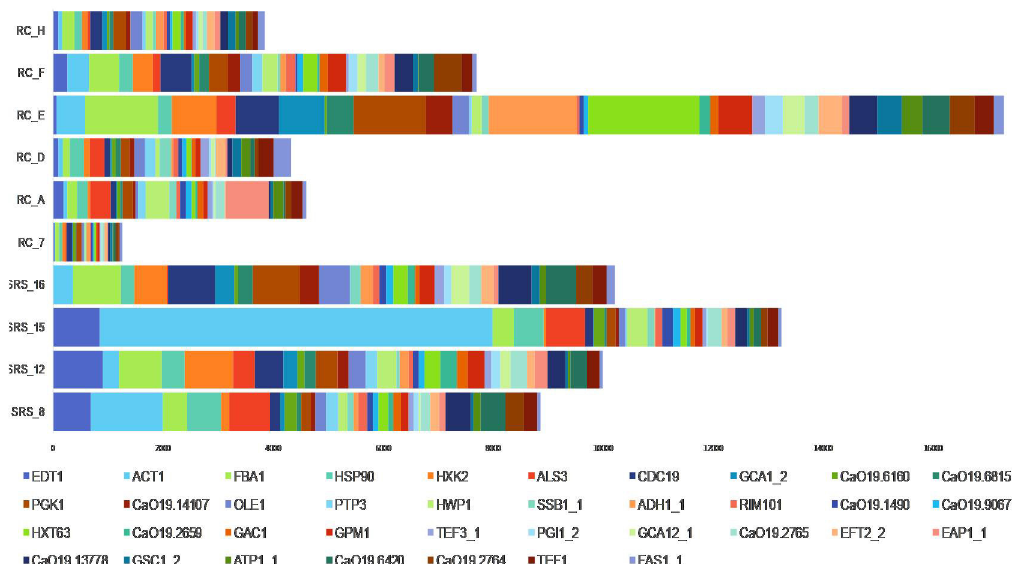
Figure 1- Relative median expression (RME; log10) of genes in the Sound Root Surfaces (SRS; n=4) and Root Caries (RC; n=6) samples. RME was calculated from the median values of normalized read counts. The top median RME values for SRS and RC were selected and sorted, and indicate the most expressed genes by C. albicans